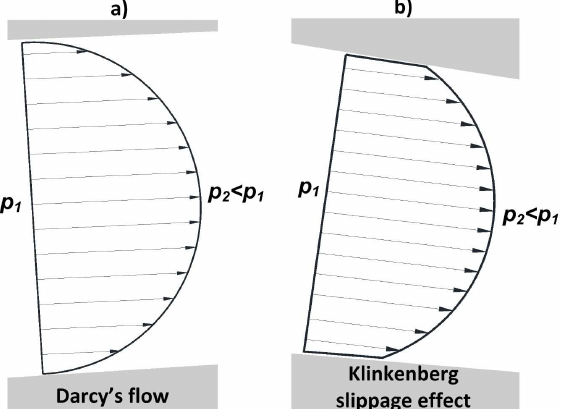
Figure 1. Gas flow in the pore space according to Darcy ( a ) and taking into account the Klinkenberg slippage effect ( b ).